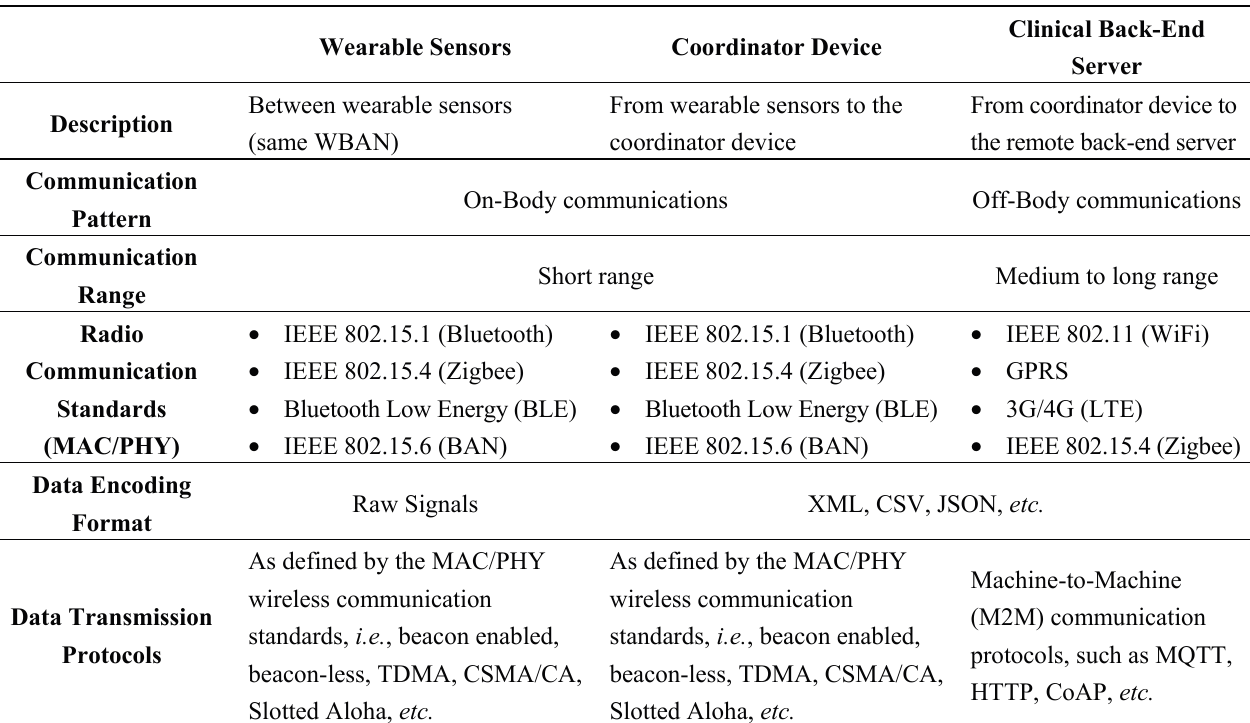
Table 1. Key enabling technologies and standards for future mHealth